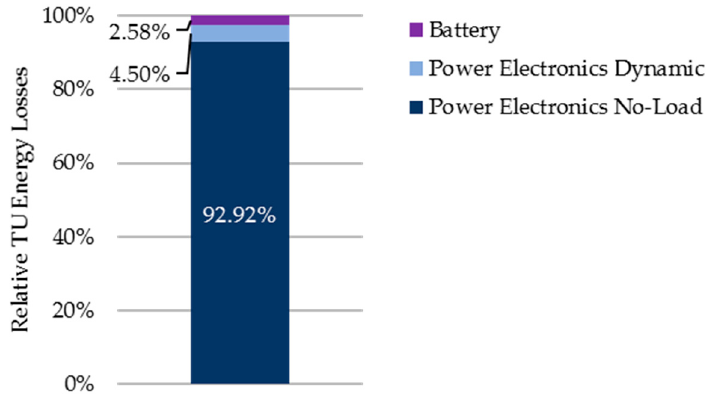
Figure 5. Technical Unit energy loss analysis based on model data for March 2017.